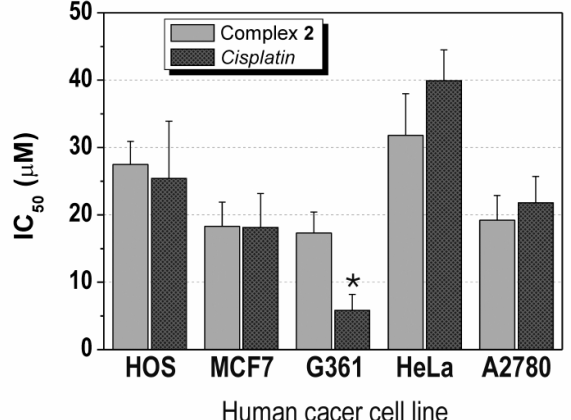
Asterisk ( * ) symbolizes significant difference ( p < 0.05) in in vitro antitumour activity of 2 as compared to cisplatin ; nt = not